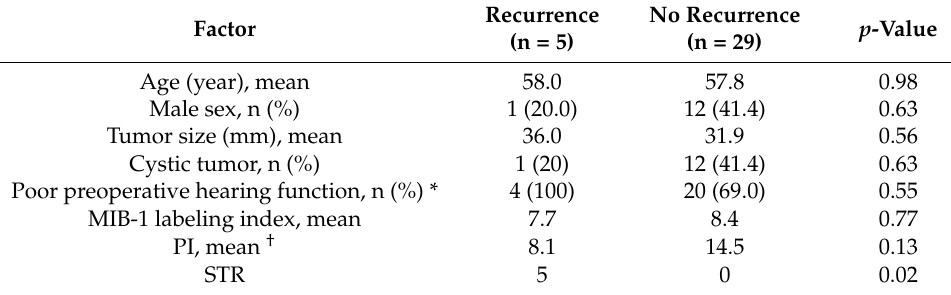
Figure 2. ( A ) Correlation between the proliferation index (PI) and MIB-1 labelling index (R = 0.57, p < 0.0001). ( B ) PI are plotted on the left (intrameatal portion) and right (cisternal portion) columns. Specimens from the same tumor are denoted by straight lines. ( C ) Delta PI (intrameatal portion— cisternal portion) are plotted. Note that most tumors demonstrate intratumoral heterogeneity in the PI. Table 2. Univariate analysis of factors associated with recurrence (n =